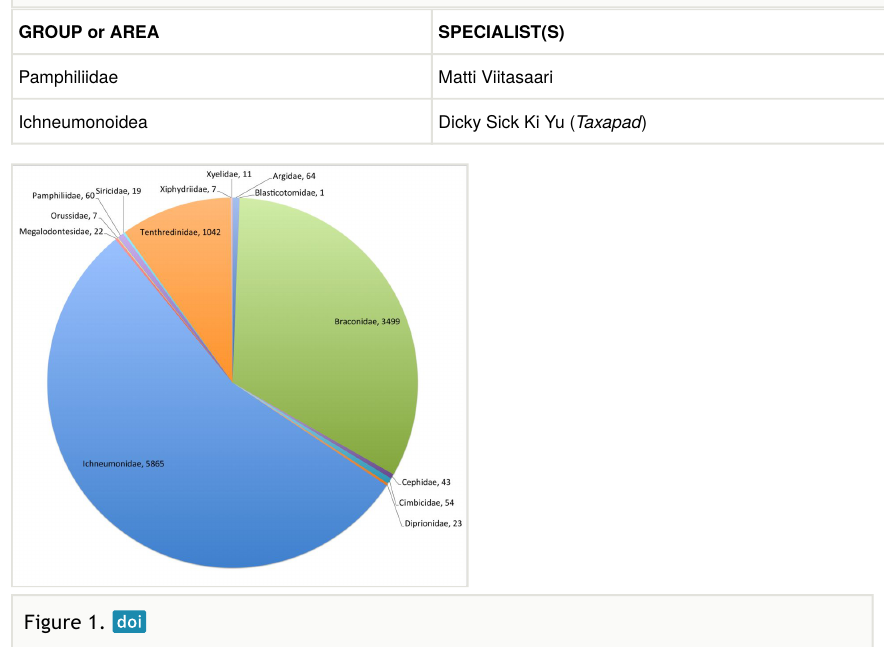
Figure 1. FaEu Hymenoptera (Symphyta & Ichneumonoidea) species per family. See Table 1 for family